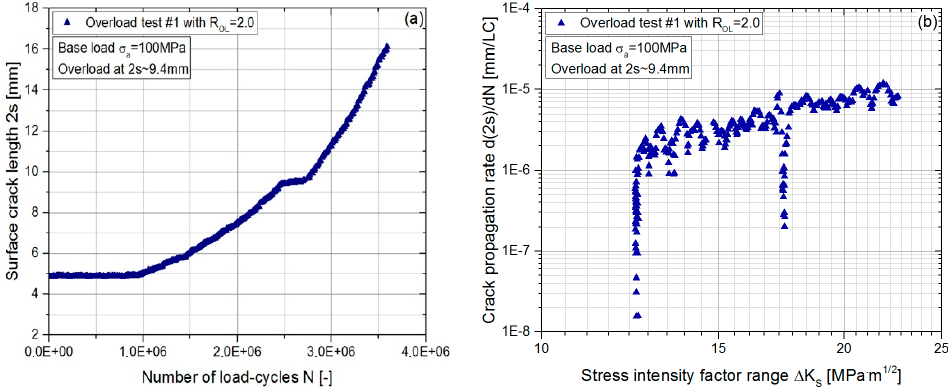
Figure 5. Results of Overload test #1 with R OL = 2.0 ( a ) surface crack length versus load-cycles; ( b ) crack propagation rate vs. stress intensity factor.